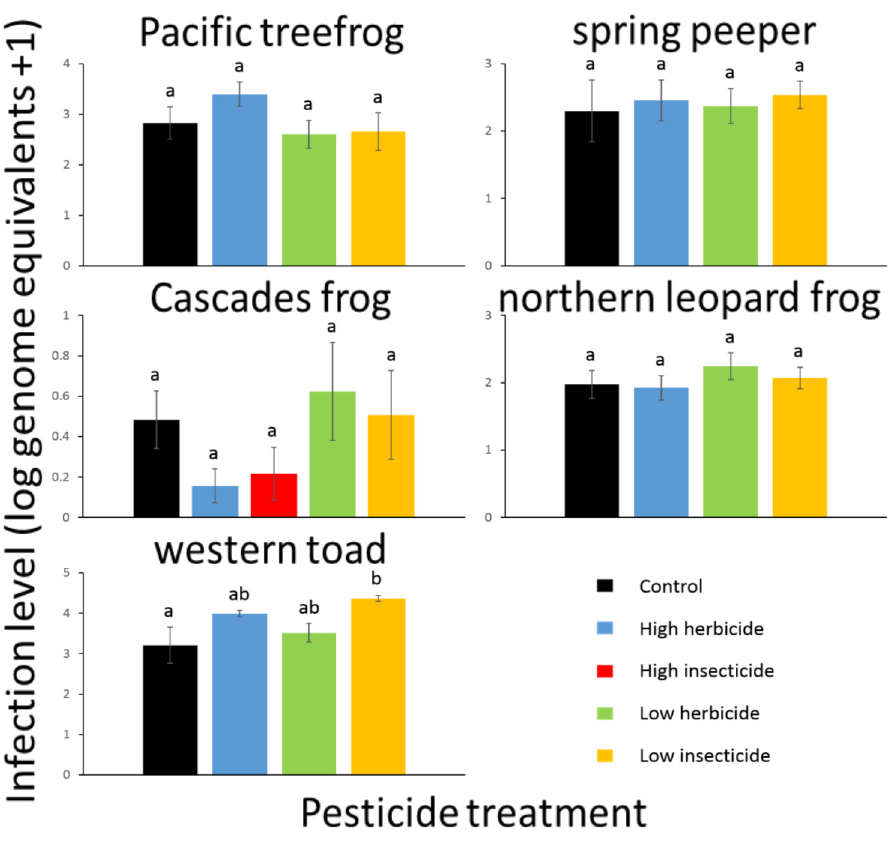
Fig 2. Infection level (log genome equivalents +1) for Bd-exposed amphibians exposed to pesticides as tadpoles. Species are arranged phylogenetically (rows) and by geographic origin (columns). Values plotted are means ± 1SE.